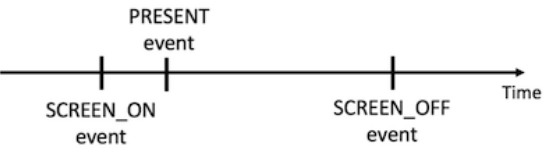
Figure 1. Different screen events recorded by the mQoL-log (Left: Screen ON and OFF; Right: Screen turned ON, unlocked (PRESENT), and turned OFF). mQoL-log: mobile Quality of Life